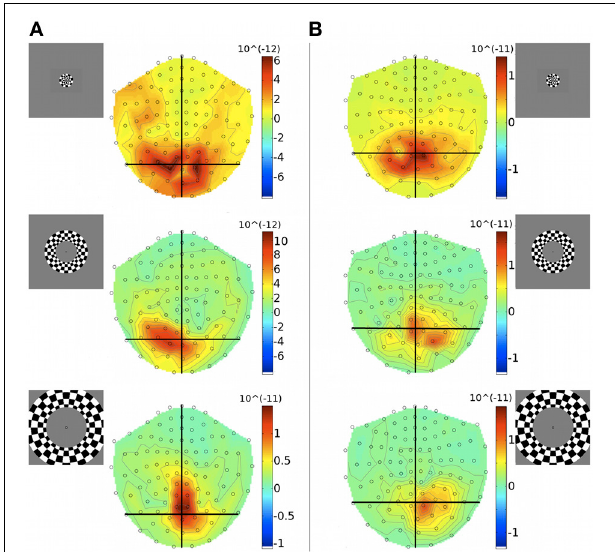
FIGURE 4 | Gradiometer topography maps (T/m) of the averaged evoked responses to concentric ring stimuli at 83ms post-stimulus, for Subjects 1 (A) and 4 (B). Eccentricities ECC 1, ECC 2, and ECC 3 are presented at the top, middle, and bottom, respectively. Insets indicate stimulus locations.